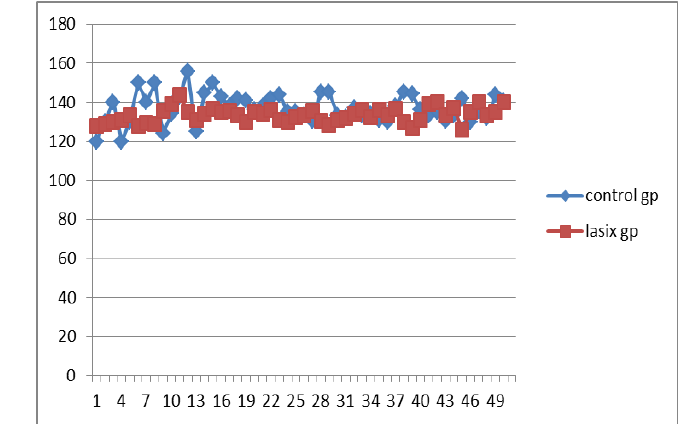
Figure (8): shocked patients received normal saline versus shocked patients received Furosemide in terms of ICU admission, there is significant statistical difference(p=0.001).